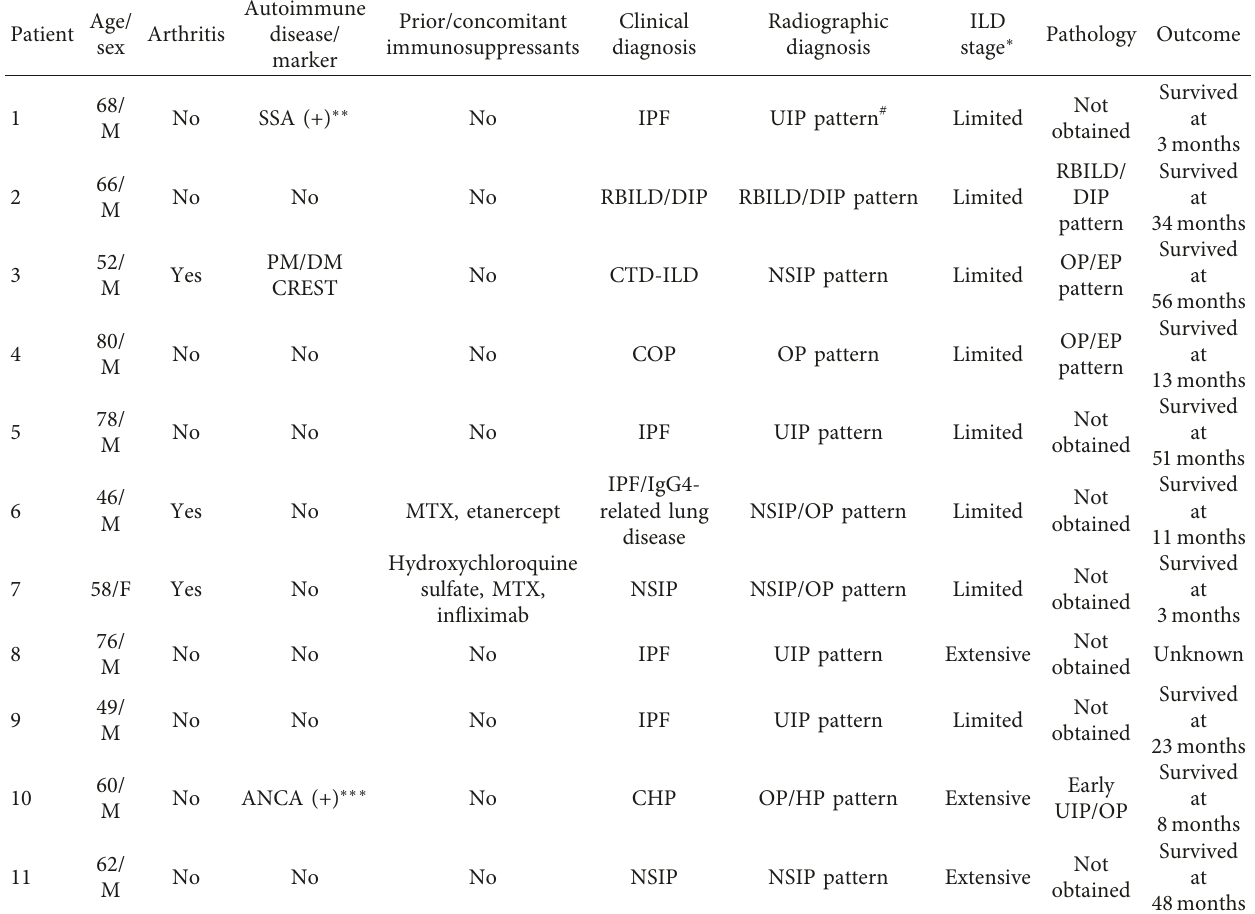
Table 2: Demographic and clinical features of 21 ILD patients with